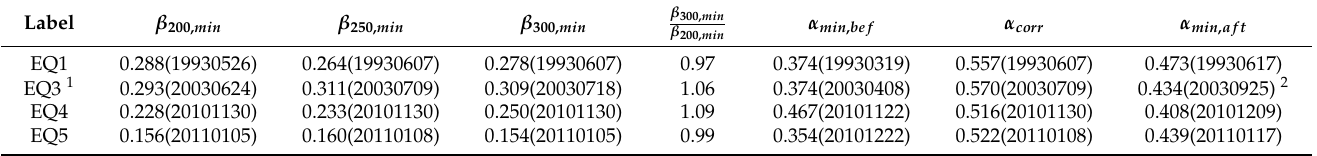
Table 3. The values of β W , min , α min , bef , α corr and α min , aft in the smaller area N 46 sliding natural time windows of length 6 to W that preceded M JMA ≥ 7.8 EQs. Reproduced